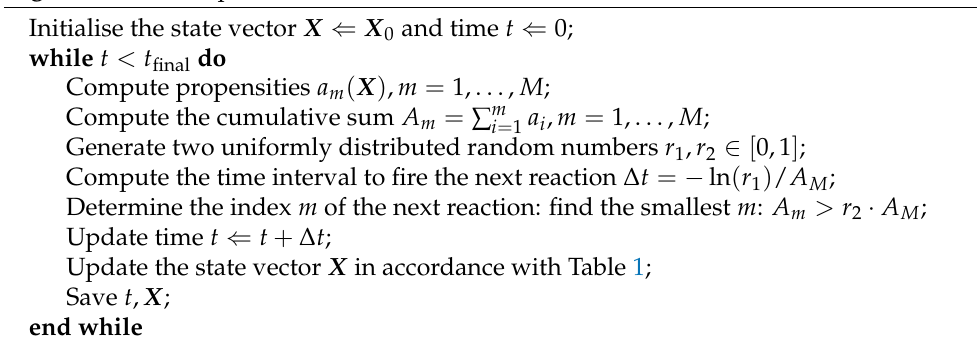
Algorithm 1: Gillespie’s direct